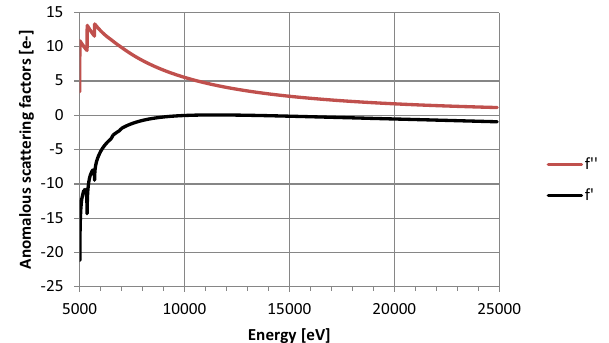
Figure 1. Anomalous scattering of cesium plotted against energy. The plot was generated with data from 27